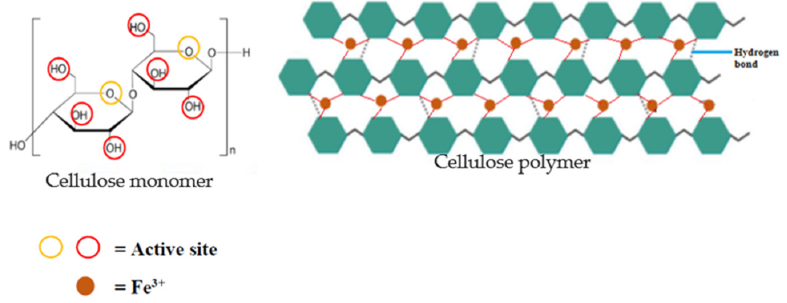
Figure 8. Schematic mechanism of interaction between Fe(III) ions and cellulose of C–PPF.